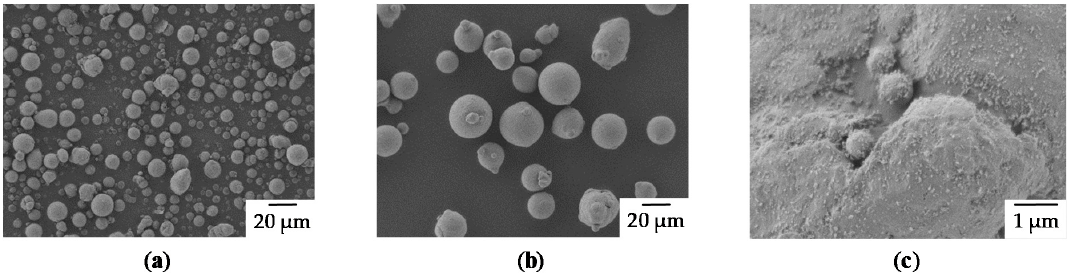
Figure 5. ( a ) Fine particle fraction (EHT = 1 keV, WD = 6 mm, Mag = 500×) ( b ) Corse particle fraction (EHT = 1 keV, WD = 6 mm, Mag = 500×) ( c ) Surface of a particle covered with SiO x (EHT = 1 keV, WD = 5 mm, Mag = 15.000×).